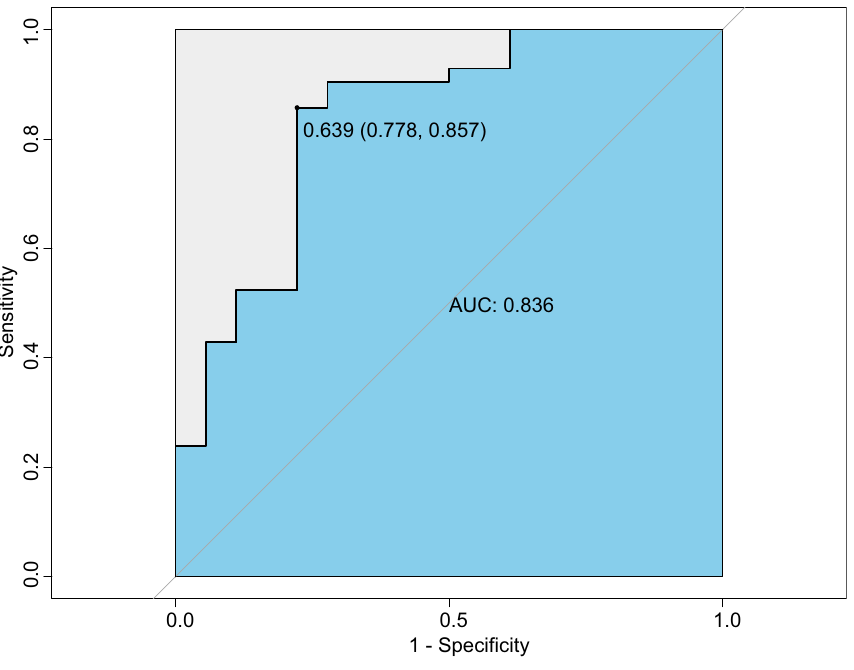
Figure 7. ROC curve showing discrimination effective of nomogram used in PLA2R-negative MN and primary NS caused by other